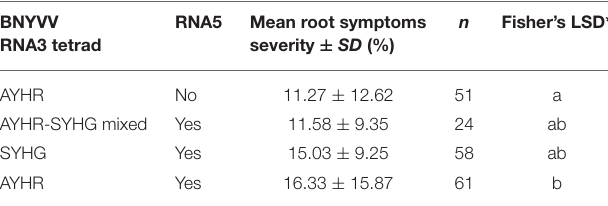
TABLE 6 | Mean root symptoms severity values for BNYVV tetrads with or without RNA5 independently of the